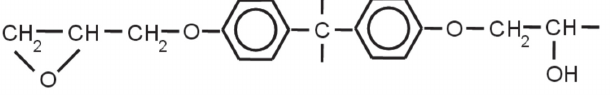
Figure 2. The chemical formula of epoxy resin. Table 2. Selected physico-chemical and mechanical characteristics of Epidian 601 (CIECH Ż ywice, Nowa Sarzyna, Podkarpackie voivodeship, Poland) [48].